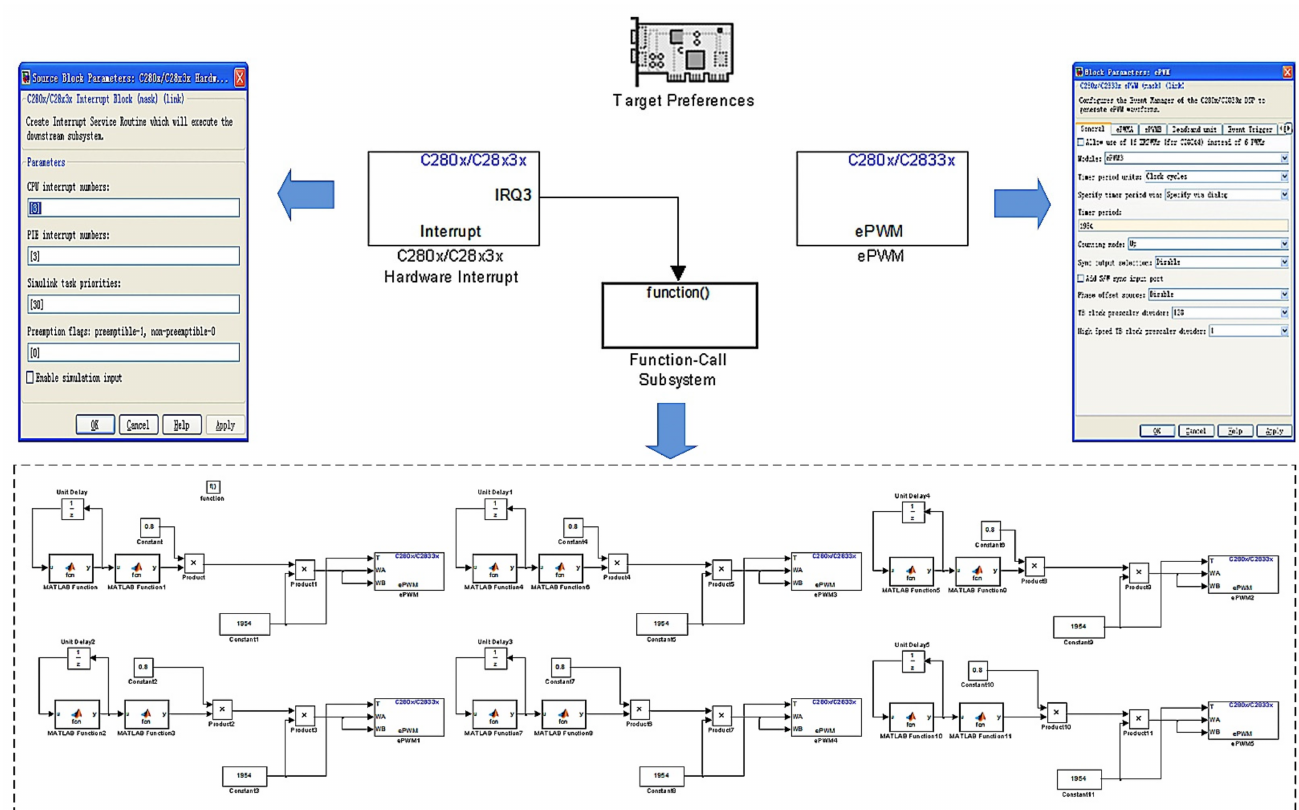
Figure 9. Code-generation